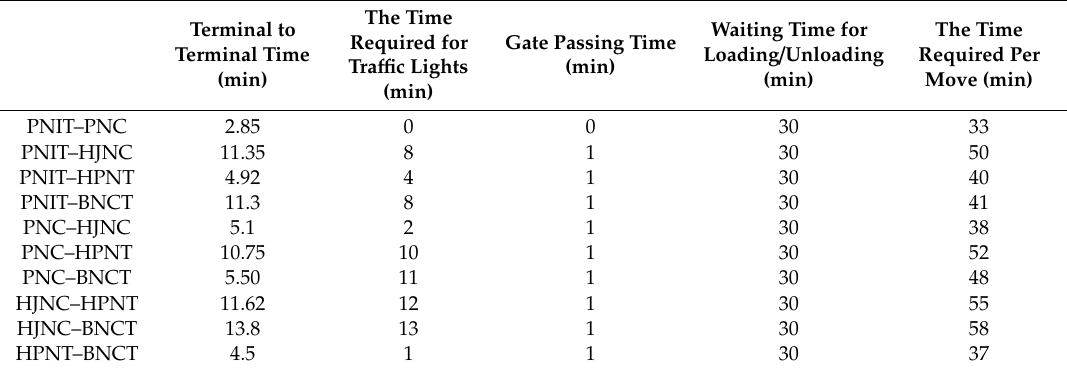
Table 3. Estimated container processing time per move [32].